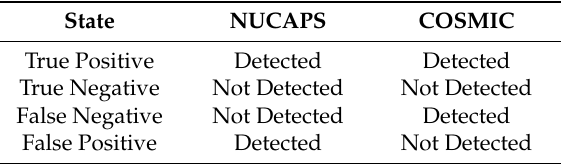
Table 1. A summary of detection states. “Detected” indicates that a temperature of 208 K was detected within the profile for the listed product. COSMIC is the observational “truth” in this